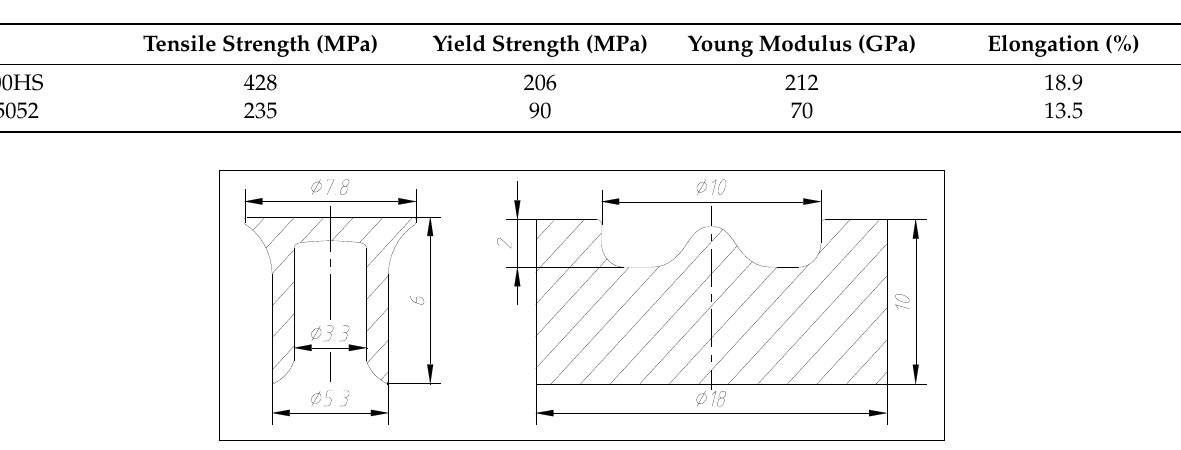
Table 2. Mechanical properties of B1500HS and AA5052 sheets.